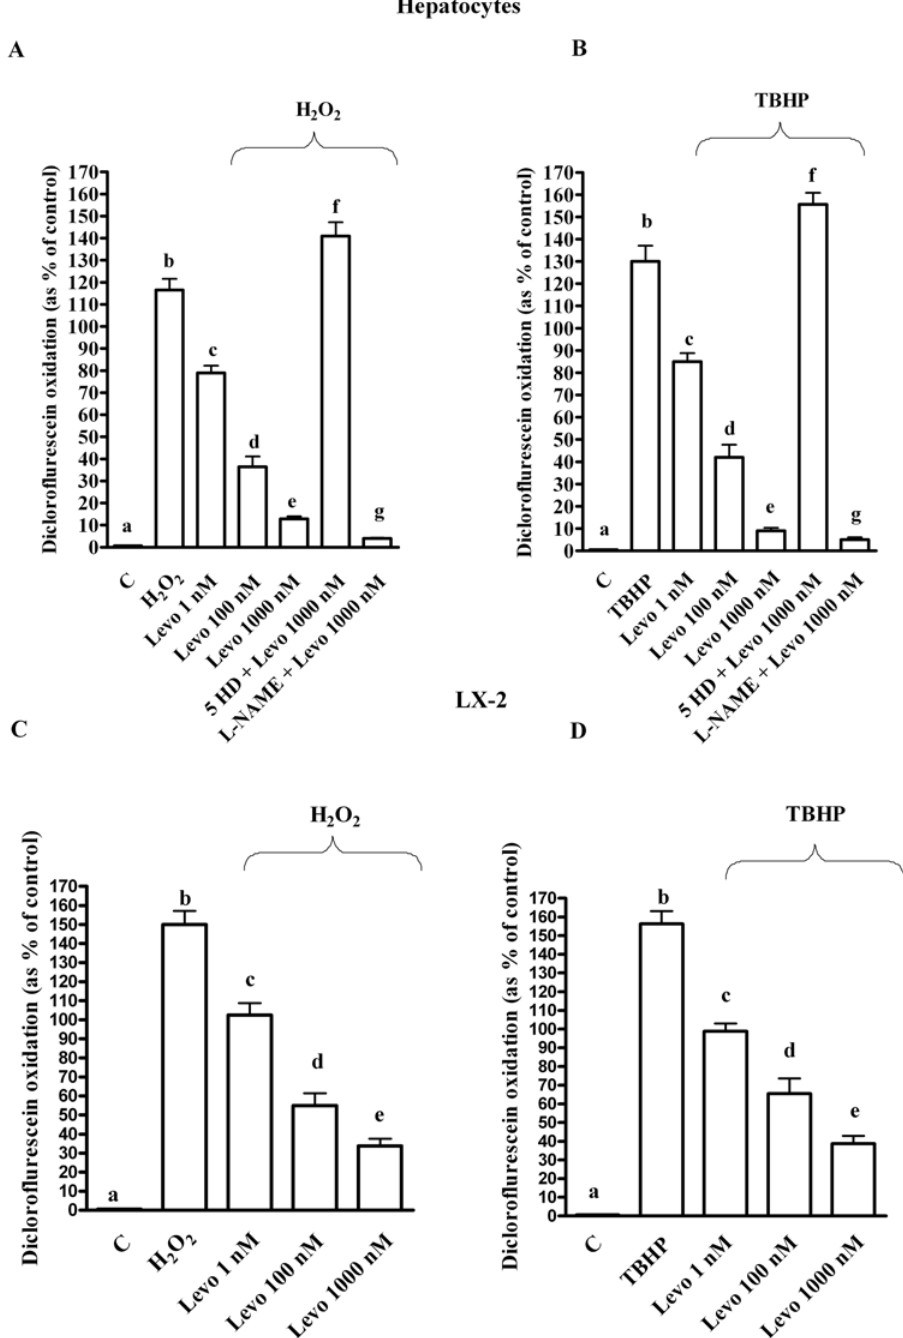
Fig 2. Effects of levosimendan against reactive oxygen species production measured as diclorofluorescein oxidation in hepatocytes and LX-2. In A and B, b, c, d, e, f, g P < 0.05 vs a; c, d, e, f, g P < 0.05 vs b; d, e P < 0.05 vs c; d, f, g P < 0.05 vs e. In C and D, b, c, d, e P < 0.05 vs a; c, d, e P < 0.05 vs b; d, e P < 0.05 vs c; e P < 0.05 vs d. Abbreviations are as in Fig 1. The results obtained in hepatocytes and LX-2 are expressed as means of 5 or 4 independent experiments (%) ± SD (indicated by the bars), respectively.